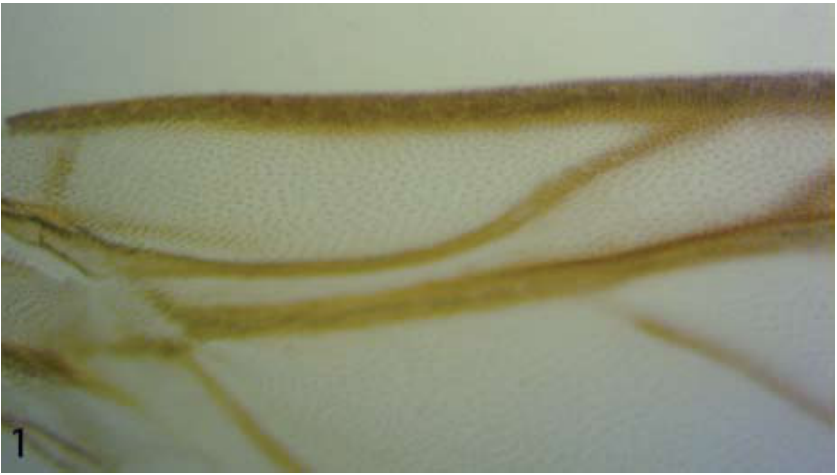
Fig. 1. Rhynchomicropteron curvescens male, costal section